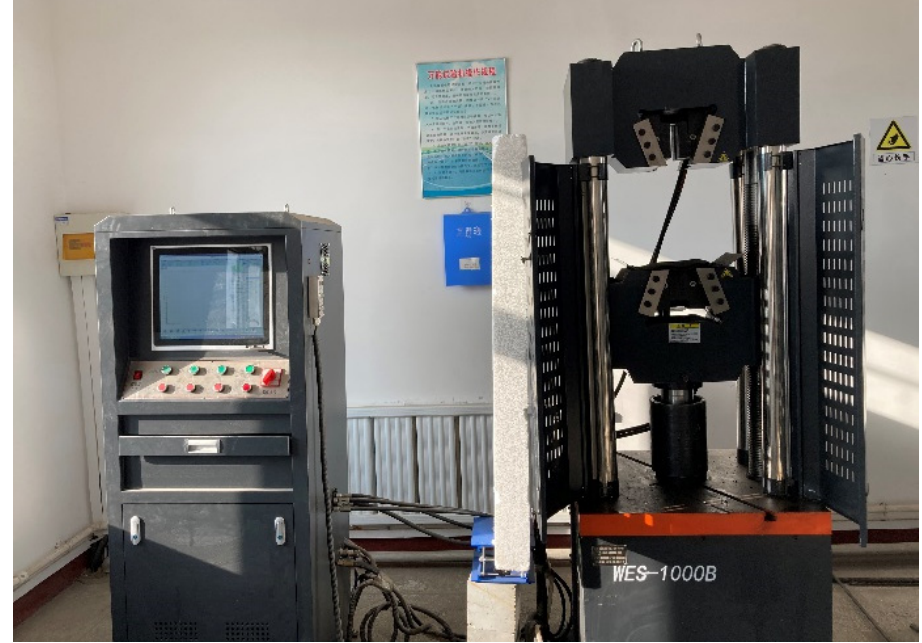
Figure 1. Electro-hydraulic servo universal material testing machine and compacting device.